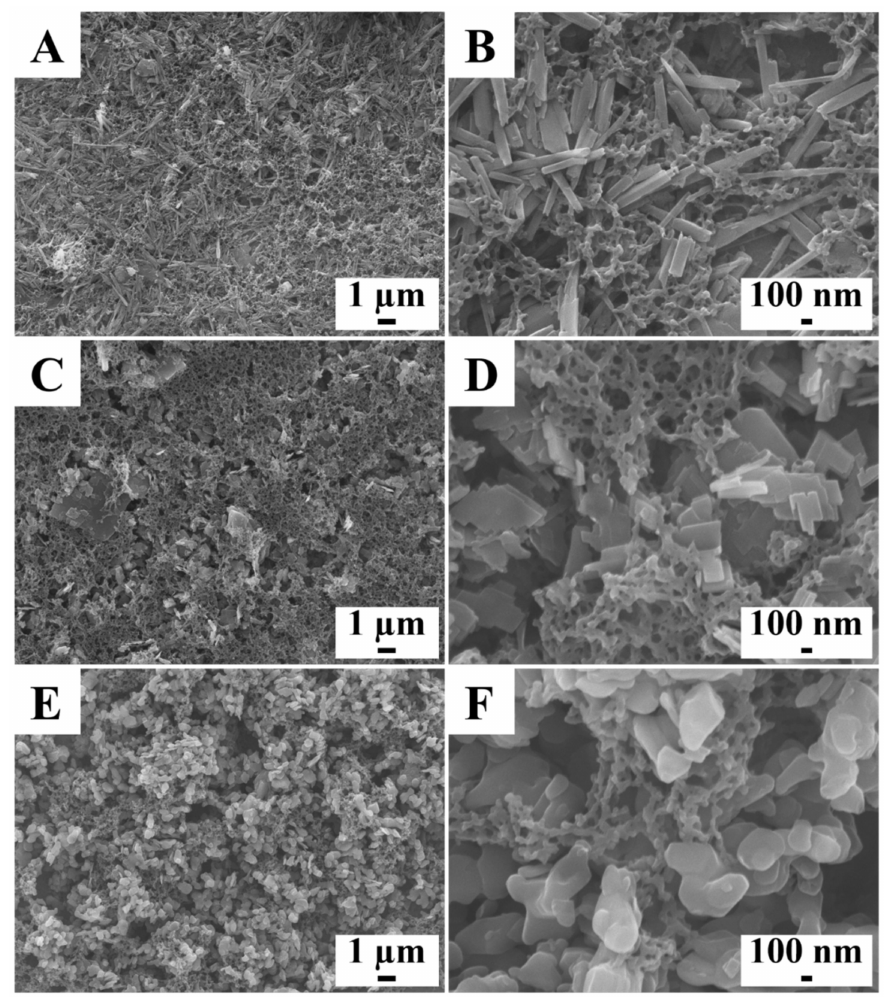
Figure 4. SEM images for ( A , B ) PMMA-halloysite, ( C , D ) PMMA-huntite, and ( E , F ) PMMA-hydrotalcite coatings, prepared from 10 g L − 1 solutions of PMMA with R wip = 0.25, containing 10 g L − 1